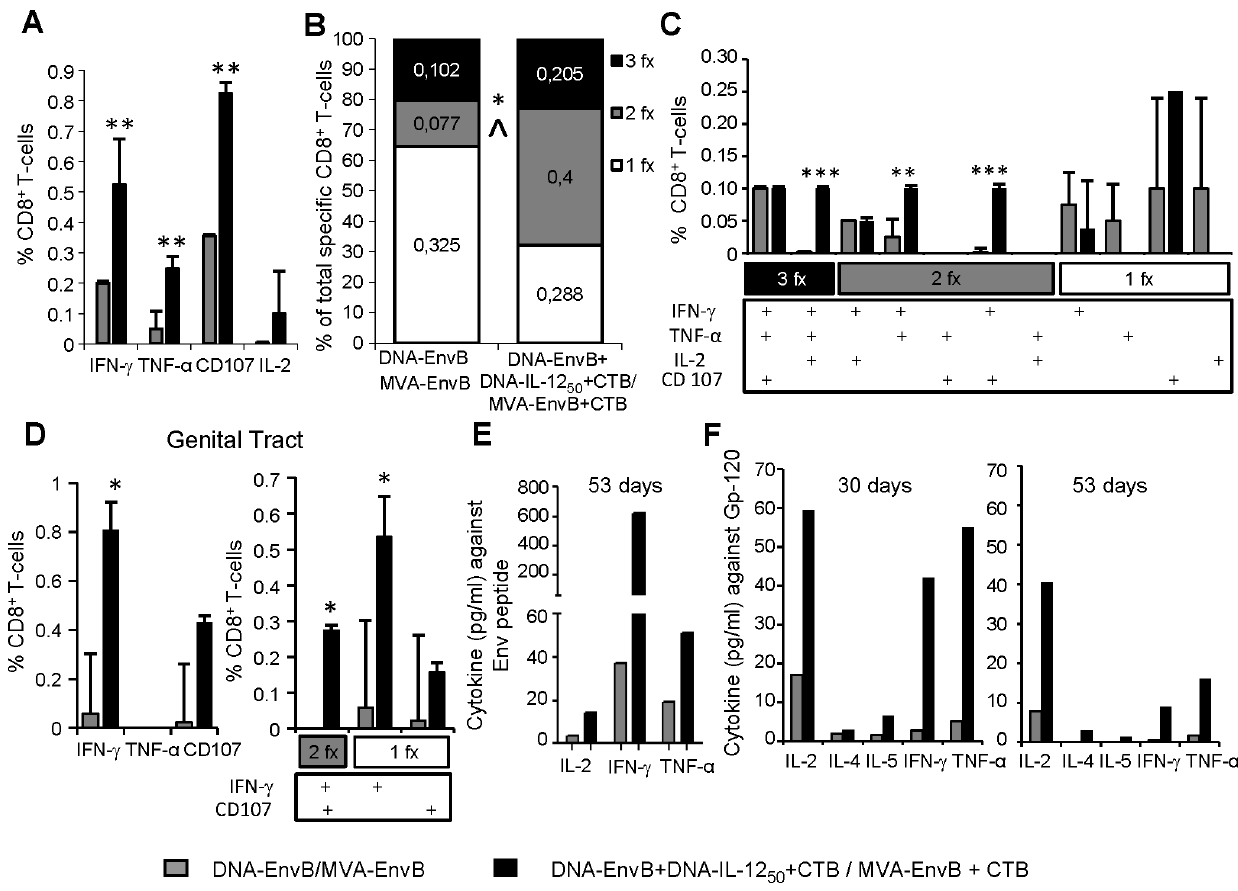
Figure 4. Mucosal IL-12 plus CTB modulates the T-cell capacities of cytotoxicity and specific cytokine pattern production in spleen and genital tract. Quality of the response was evaluated in pooled samples from six mice immunized as DNA-EnvB/MVA-EnvB (grey bars) and DNA- EnvB + DNA-IL-12 50 + CTB/MVA-EnvB + CTB (black bars) groups. (A) Ten days after the MVA boost, the proportion of cytokine secreting (IFN- c , TNF- a and IL-2) and cytotoxic (CD107a/b) specific CD8 + T-cells against V3 loop were determinated by ICS in splenocytes. (B) Considering the total of specific CD 8 + T-cells, percentages of monofunctional (1fx, white), bifunctional (2fx, grey) and trifunctional (3fx, black) cells are represented. (C) Percentages of specific CD8 T-cells detailing the function performed. (D) The same analysis performed in (A) and (C) was done for genital tract cells. The percentage of specific CD8 T-cells able to secrete IFN- c , TNF- a , or with cytotoxicity capacity (CD107a/b + cells) and polyfunctionality are depicted in the left and right panel respectively. Bars represent the average + SD for duplicate of pooled cells from six mice. Statistical differences between groups: *p , 0.05; **p , 0.01; ***p , 0.001 by Student’s T test (E) 53 days after the boost dose, splenocytes from immunized mice were stimulated with V3 loop peptide during 72 h and cytokines were measured in culture supernatants using the mouse Th1/Th2 cytokine cytometric bead array (CBA). (F) 30 and 53 days after the MVA boost, splenocytes were stimulated with recombinant Gp-120 protein and cytokines were measured as in (E). Bars represent the average values + SD of duplicate determinations from pooled samples. Background values of negative control (RPMIc) were subtracted. Responses were considered as positive if they were above the cut-off values (RPMI + 3SD).